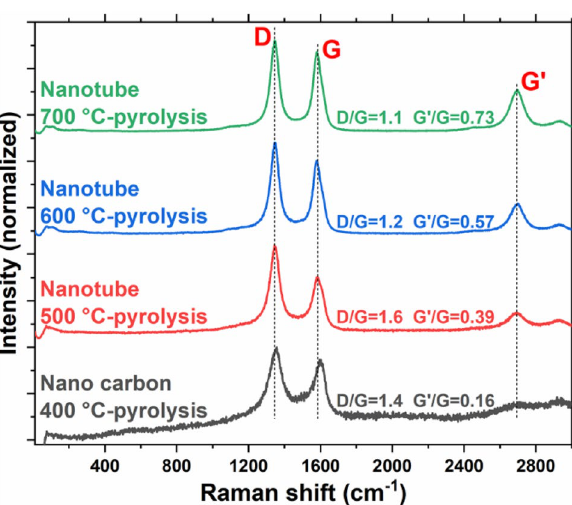
Figure 3. Raman spectra of surface carbon formed from 30-min CH 4 pyrolysis at 400, 500, 600 and 700 °C respectively on 200 mg 20 wt% Ni/Al 2 O 3 at a flow rate of 30 ml/min. The ratio of the intensity of D/G peaks is a measure of the defects present on carbon